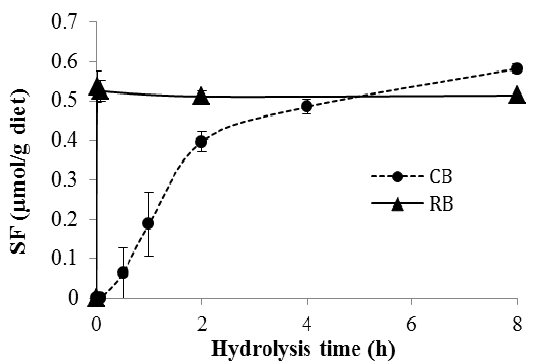
Figure 1. Sulforaphane production by 10% raw broccoli (RB) diet and 10% lightly cooked broccoli (CB) diet after in vitro hydrolysis for 1 min, 5 min, 2 h, and 8 h (RB) and 1 min, 5 min, 30 min, 1 h, 2 h, 4 h, and 8 h (CB), respectively. Data are mean ± SE ( n = 3–5).